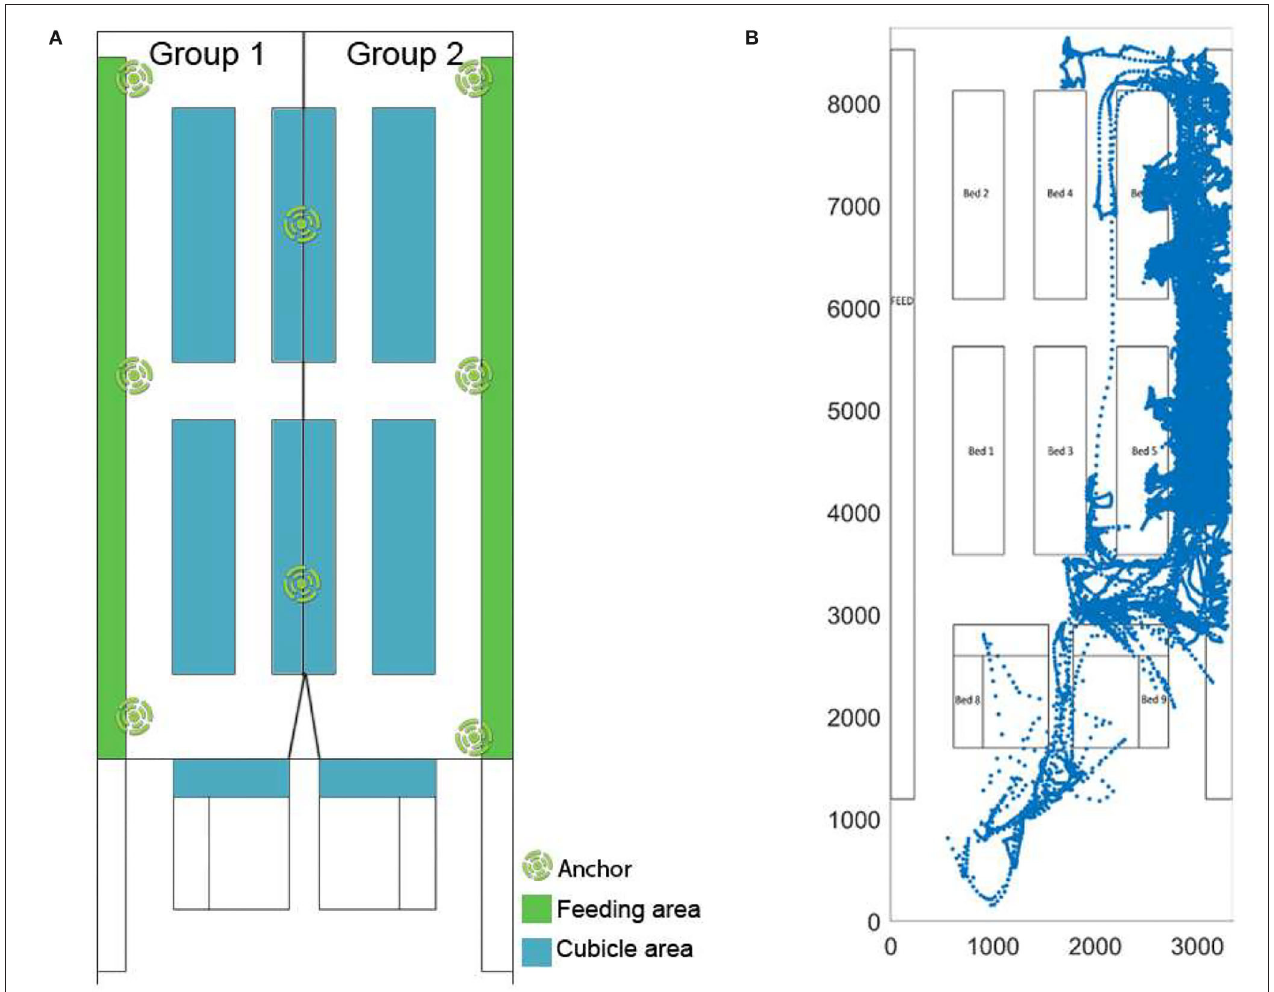
FIGURE 1 | (A) Layout of the barns equipped with the CowView system (GEA Farm Technologies). The barn under study (74 × 33m) has feeding alleys on both sides of the barn toward the wall, and cubicles are in the central parts of the barn. (B) One example of a cow’s trajectory of a day (24